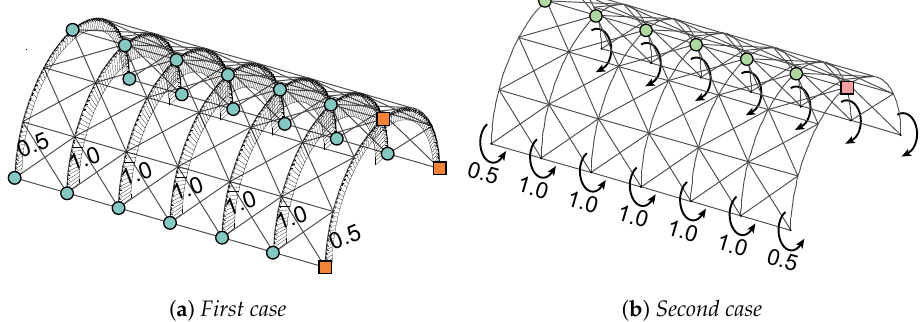
Figure 12. Load and boundary